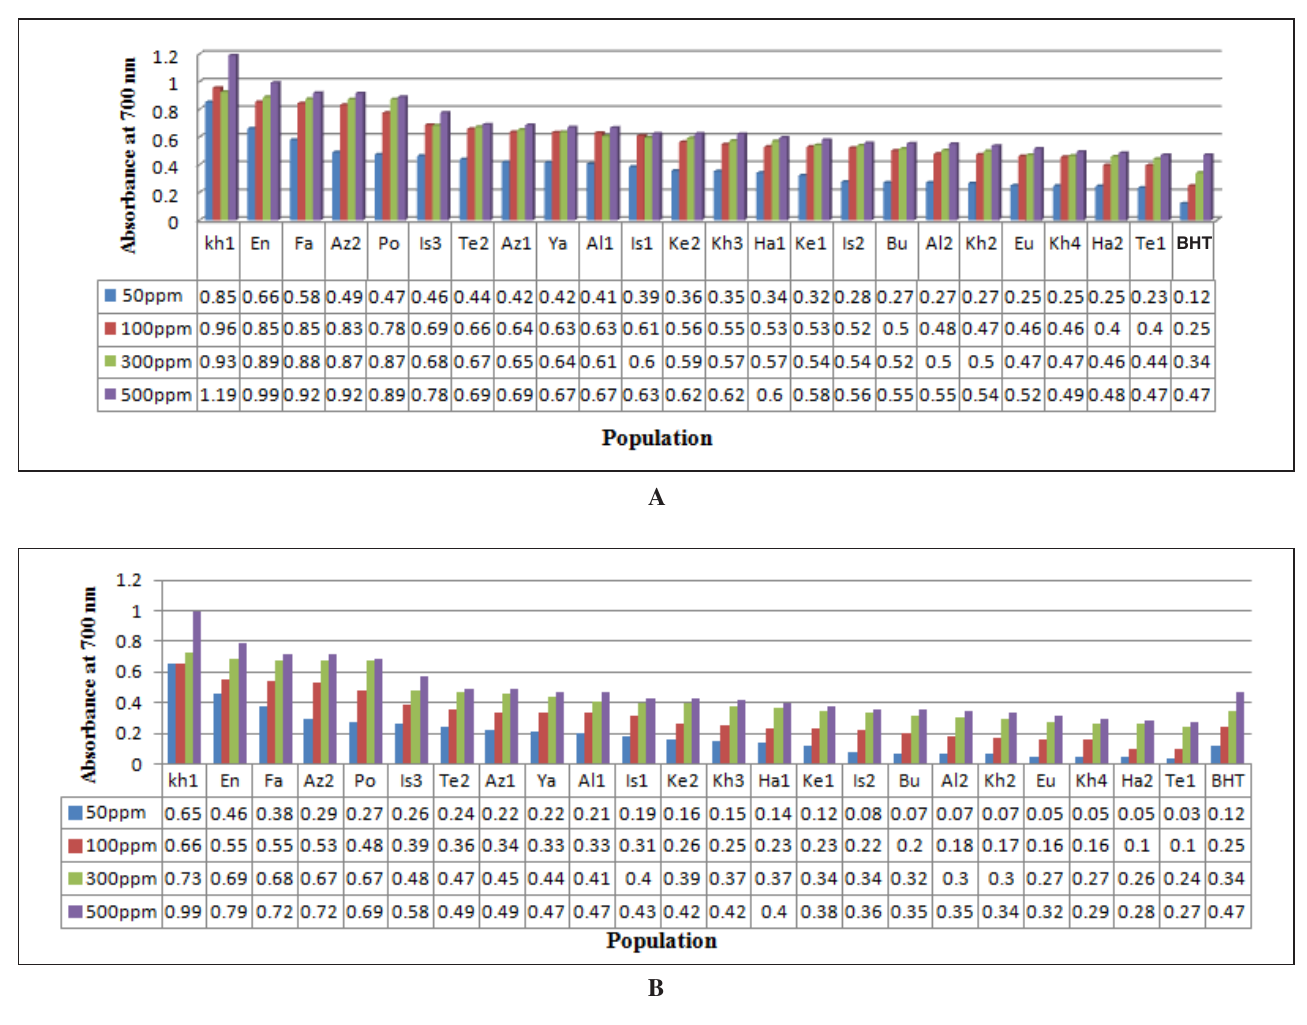
Fig. 4: Reducing power of outcross (A) and self-pollinated (B) population fennel extracts compared to BHT.